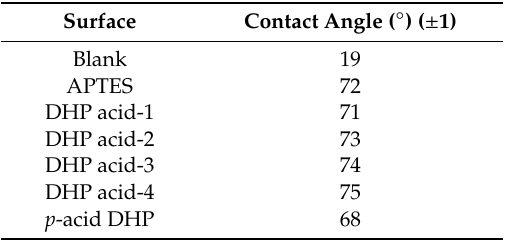
Table 3. Contact angle measurements of glass